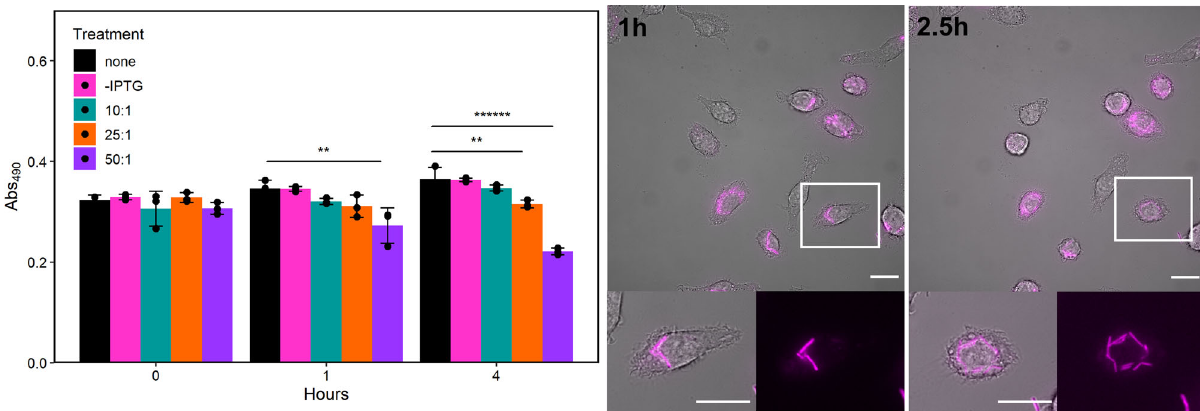
Fig. 3 Host cell viability and replication of the LLO strain in the cytoplasm of J774A.1 cells. J774A.1 cell viability at multiple time points after treatment with the LLO strain under various conditions (left, MTS assay). Live cell microscopy revealed the LLO strain replicating in a single host cell by comparing images at 1 h and 2.5 h post-bacterial addition (right). J774A.1 cells were visualized in bright fi eld, and the LLO strain using fl uorescence (magenta); zoomed images reveal the LLO strain replication in the cytoplasm. Plotted data is mean ± SD from n = 3 biological replicates; ** p < 0.01, ****** p < 0.000001. Scale bars = 20 µ m (upper); scale bars = 20 µ m (lower).